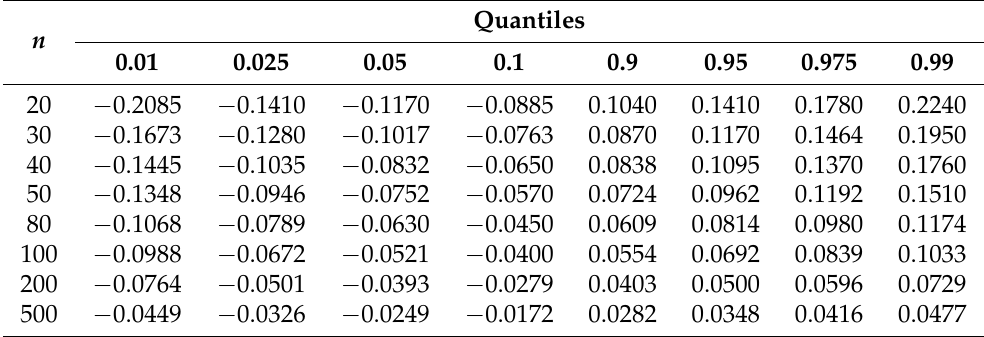
Table 6. Empirical quantiles in the Finite Mixture Model distribution of means for each sample size ( n ) (based on 5000